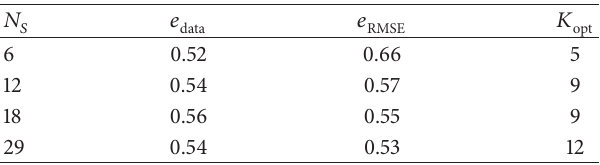
Table 2: Error measures for different values of the number of views. Homogeneous dielectric cube.